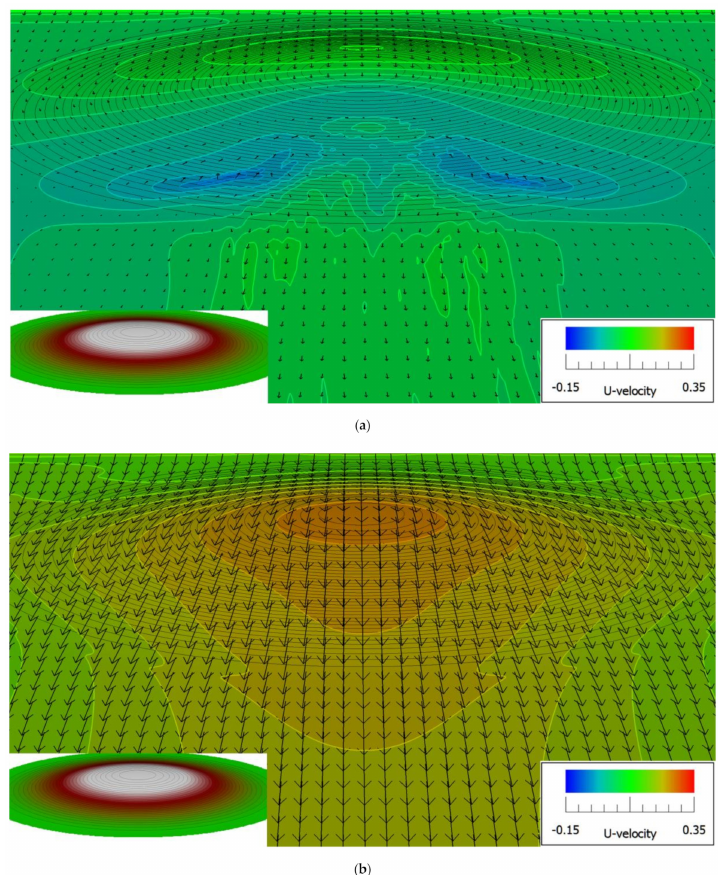
Figure 18. Comparison of surface flow patterns for a time-averaged flow field in the gentle hill scenario. ( a ) Ri = 0.0 (neutral flow); ( b ) Ri = 0.1 (stable stratified